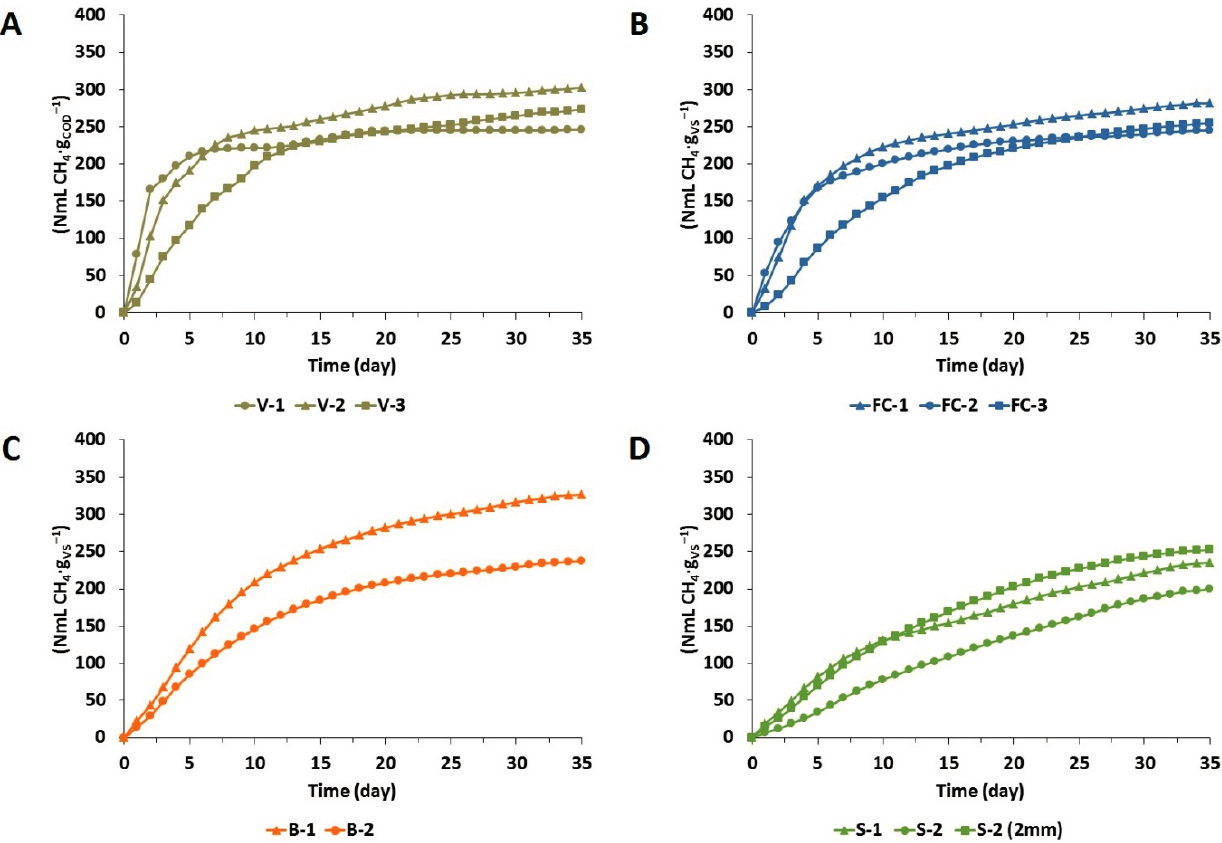
Figure 1. Cumulative methane yield of the sugarcane waste during 35 days of BMP assays. ( A ) vinasse from autonomous (V-1) and annexed plants (V-2 and V-3); ( B ) filter cake (FC-1, FC-2 and FC-3); ( C ) bagasse (B-1 and B-2); ( D ) straw (S-1 and S-2), and S-2 ground to 2 mm.